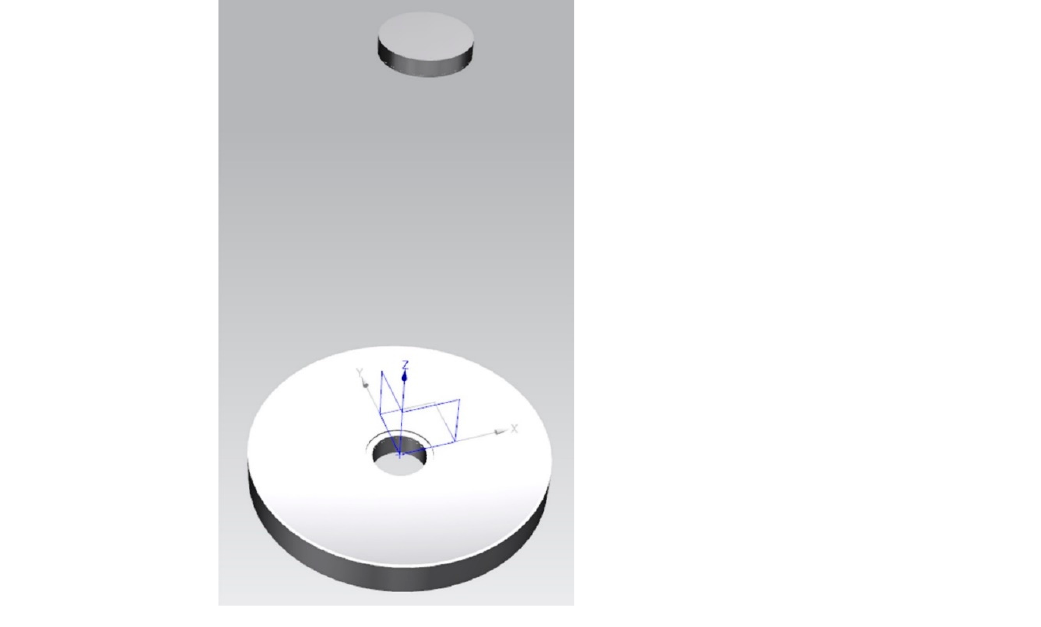
Figure 4. The Cassegrain system.